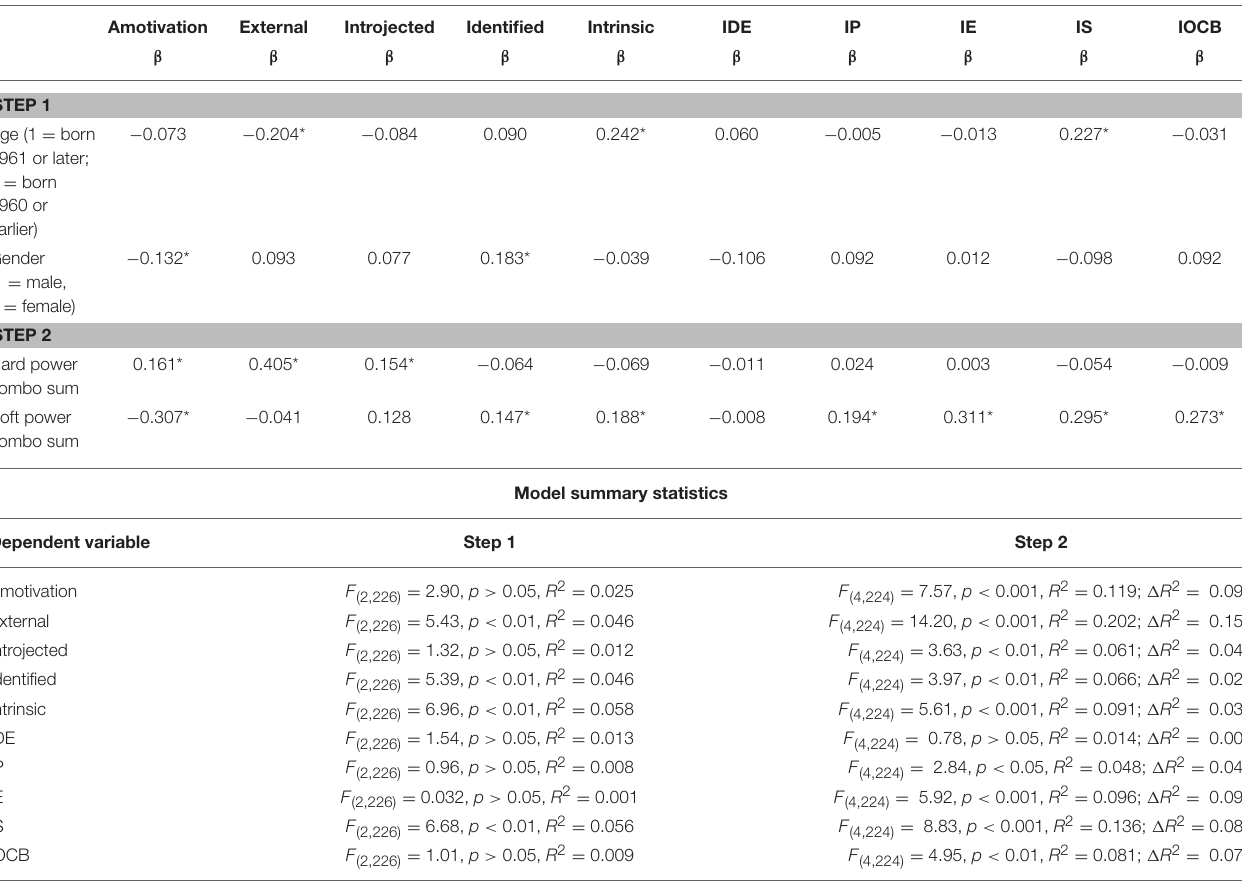
TABLE 7 | Study 1—combinations of power regression models, controlling for age and gender ( n =